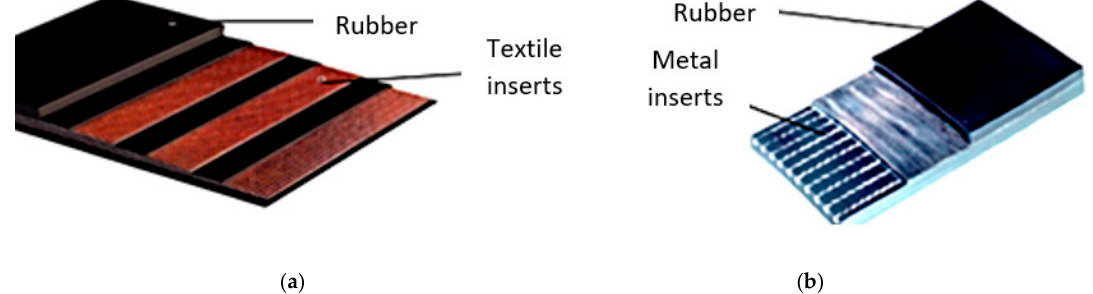
Figure 1. Structure of the conveyor belts. ( a ) with textile inserts; ( b ) with metal inserts.